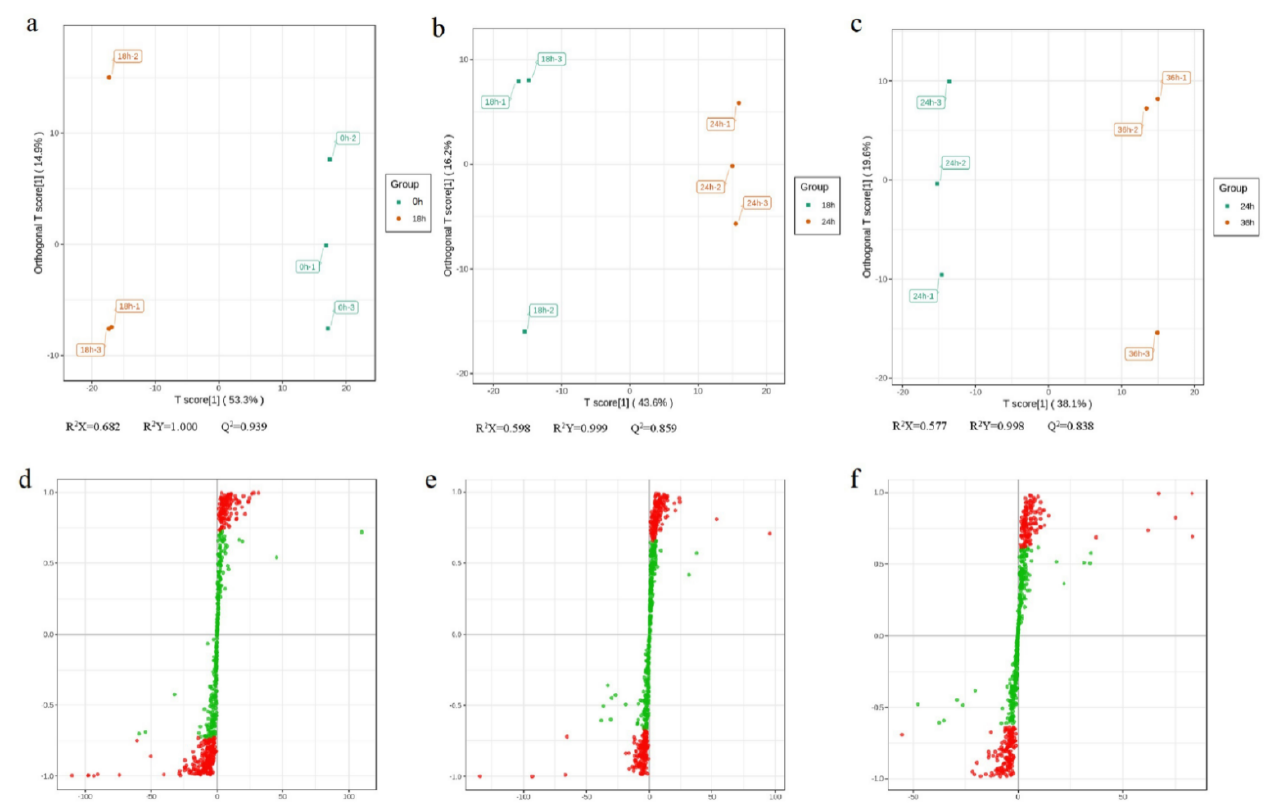
Figure 3. Orthogonal partial least squares-discriminant analysis (OPLS–DA) scores. Scores of the OPLS–DA model with ( a ) 0 vs. 18 h, ( b ) 18 vs. 24 h, ( c ) 24 vs. 36 h. OPLS–DA S-plot model with ( d ) 0 vs. 18 h, ( e ) 18 vs. 24 h, ( f ) 24 vs. 36 h. R 2 Y scores and Q 2 values represent the interpretation rate of the model to the Y matrix and the prediction ability of the model, respectively. When Q 2 > 0.5, the model can be considered an effective model, and Q 2 > 0.9 is an excellent model.